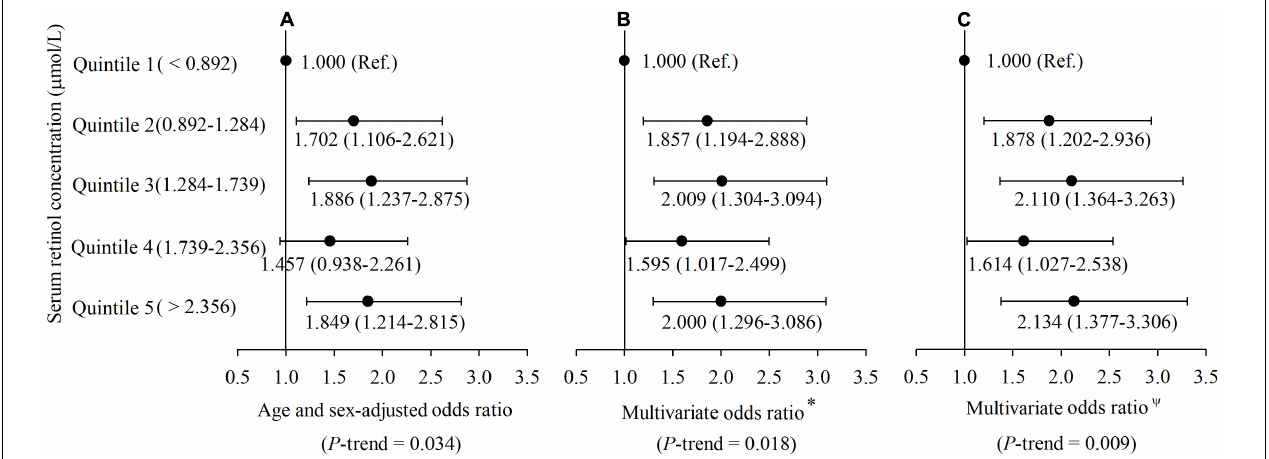
FIGURE 2 | (A–C) Adjusted odds ratios (ORs) (and 95% CIs) of type 2 diabetes risk by serum retinol at baseline. ∗ Multivariate ORs were adjusted for age, gender, current smoker, current drinker, exercising regularly, education level, physical activity, dietary vitamin A intake, dietary energy intake, and dietary lipid intake. (cid:57) Multivariate ORs were adjusted for age, gender, current smoker, current drinker, exercising regularly, education level, physical activity, dietary vitamin A intake, dietary energy intake, dietary lipid intake, body mass index (BMI), hypertension, hyperlipidemia, coronary disease, and a family history of diabetes.